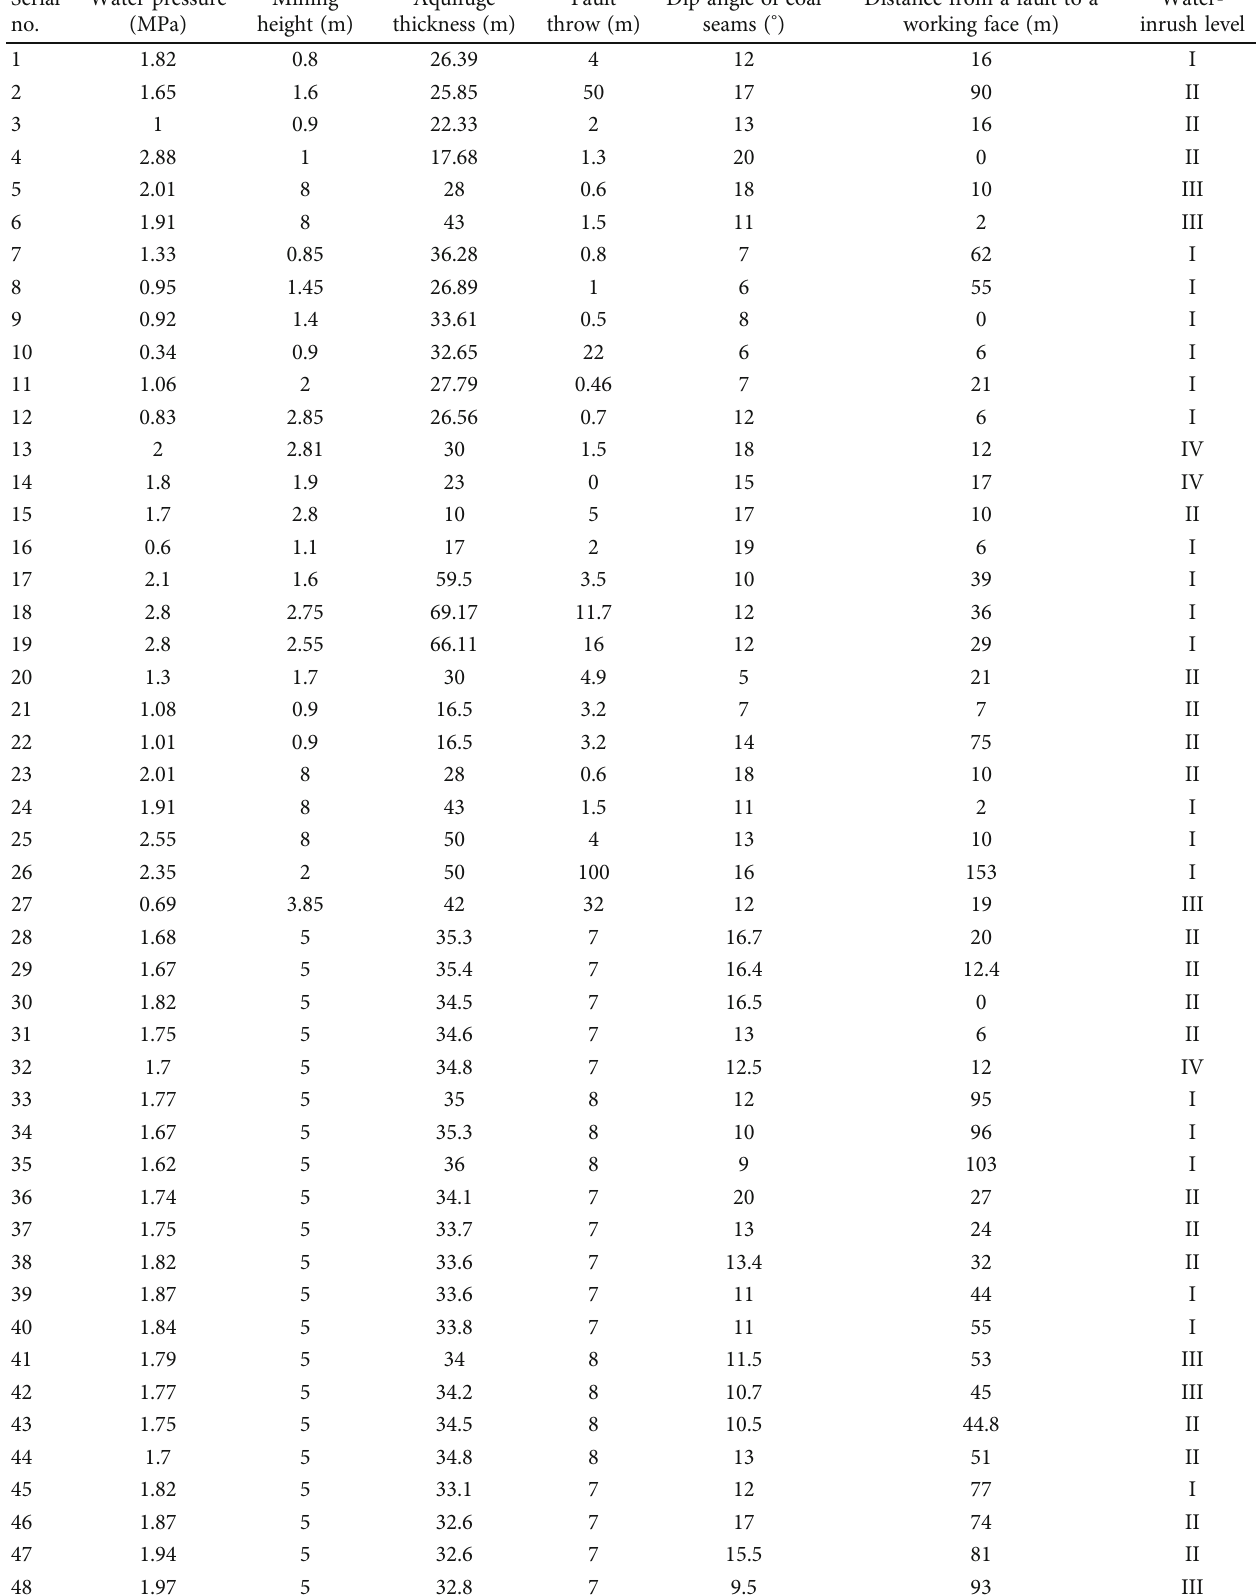
Table 2: Original data pertaining to in fl uencing